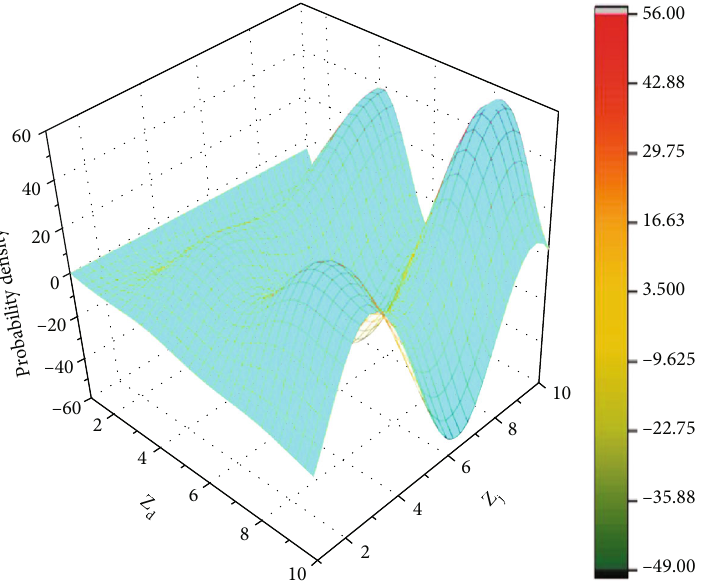
Figure 7: Lyapunov exponent and joint probability density